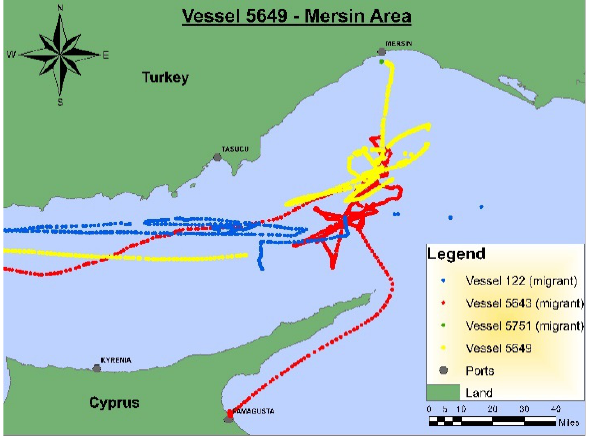
Figure 9 . Vessel 5649 - Mersin